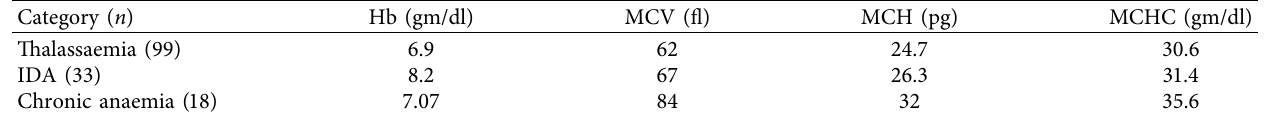
Figure 2: Retinal nerve fibre layer (RNFL) thickness in each quadrant altogether. Retinal nerve fibre layer thickness for each quadrant (mean, standard error of Table 1: Value of haemoglobin (Hb) and RBC indices in different subsets of anaemic population.